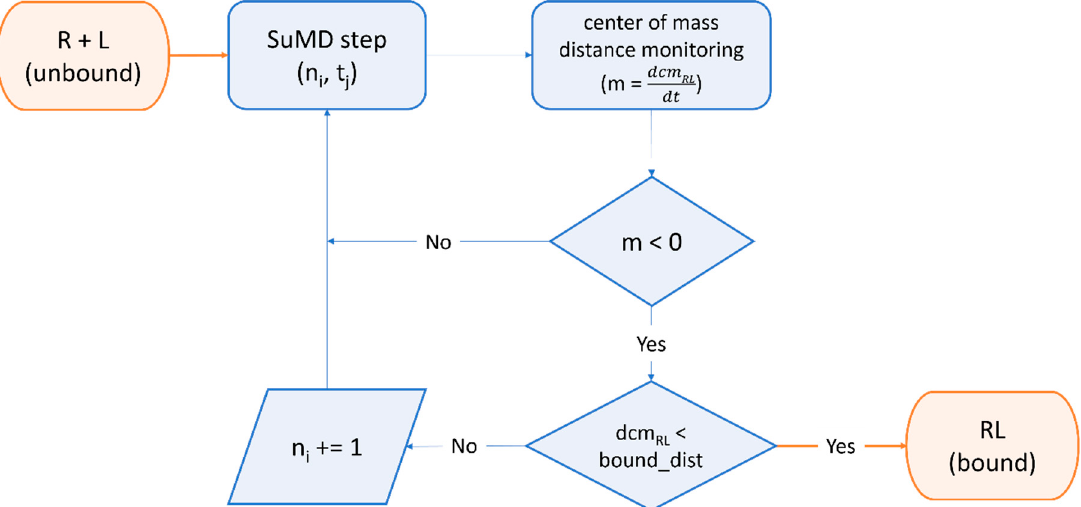
Figure 5. Workflow of a Supervised Molecular Dynamics (SuMD) simulation. The ligand is dynamically docked within a user-defined binding site through a series of short, unbiased molecular dynamics simulations. At the end of each step, the distance of mass between the ligand and the receptor binding site is computed for each trajectory frame and is fed to a tabu-like algorithm. If the slope of the straight line that interpolates the data is negative, indicating the ligand is approaching the binding site, the step is retained, and the simulation continues with the next “SuMD-step”. If not, the step is discarded and repeated, randomly reassigning particles’ velocities through the Langevin thermostat. This cycle is repeated until a threshold distance is reached or other user-defined termination criteria are